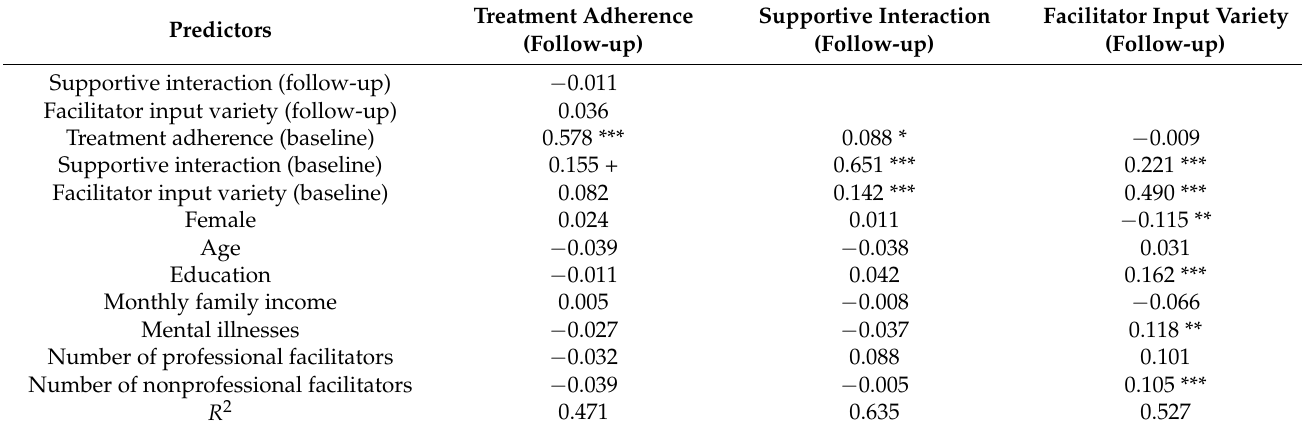
Table 4. Standardized effects of the predictors in the baseline and follow-up surveys. Treatment Adherence Supportive Interaction Facilitator Input Variety Predictors (Follow-up) (Follow-up)